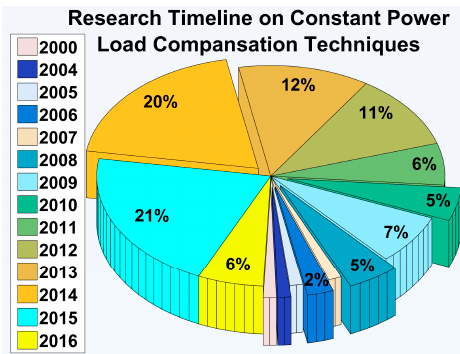
Figure 2. Research timeline on Constant Power Load Compensation Techniques, considering the published research works.